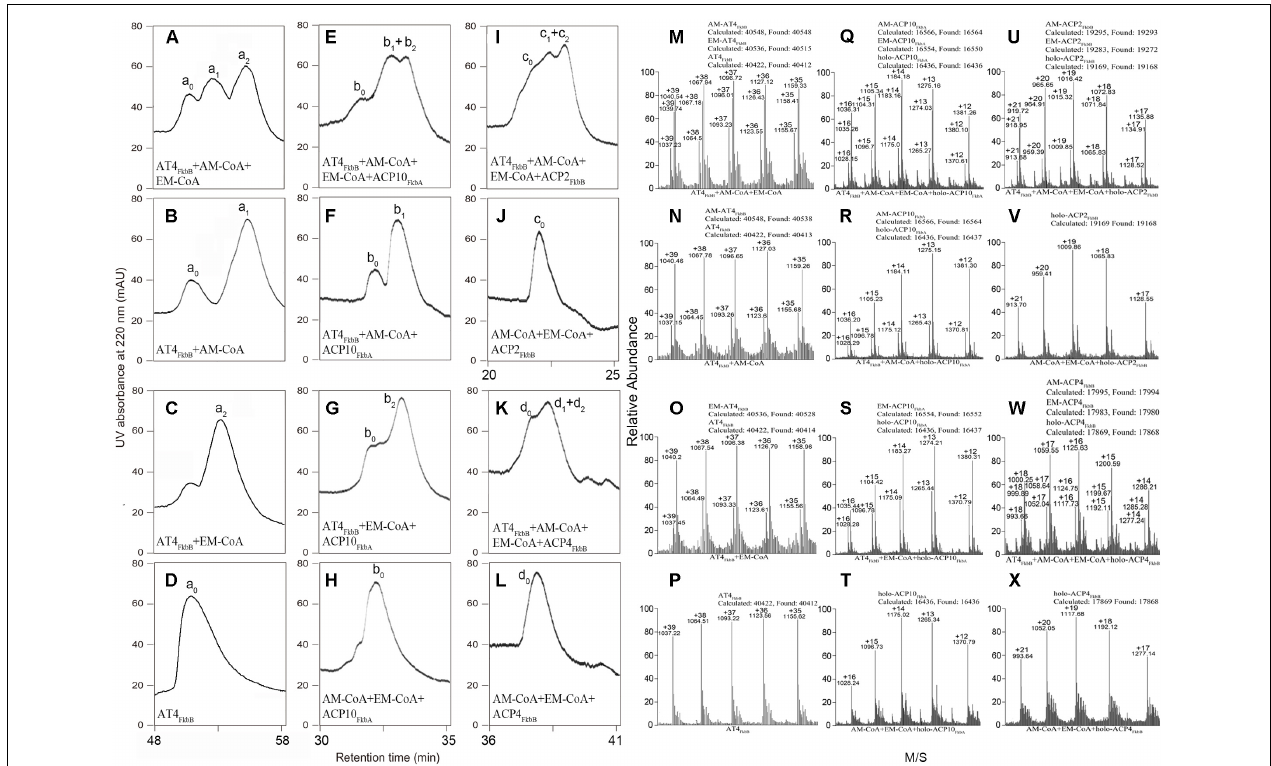
FIGURE 1 | HPLC and MS analyses of AT4 FkbB recognizing and transferring allmal- and ethmal-CoA in self -acylation reactions and onto diverse ACPs in trans -acylation reactions. (A–C,M–O) HPLC and MS analyses of incubation of AT4 FkbB with allmal-CoA : ethmal-CoA = 1:1 (A, M), allmal-CoA (B,N) , ethmal-CoA (C,O) . (D,P) HPLC and MS analyses of AT4 FkbB . (E–G,Q–S) HPLC and MS analyses of transferring allmal-CoA : ethmal-CoA = 1:1 (E,Q) , allmal-CoA (F,R) , ethmal-CoA (G,S) to holo-ACP10 FkbA in the presence of AT4 FkbB . (H,T) HPLC and MS analyses of incubation of holo-ACP10 FkbA with allmal-CoA : ethmal-CoA = 1:1. (I,J,U,V) HPLC and MS analyses of transferring allmal-CoA : ethmal-CoA = 1:1 to holo-ACP2 FkbB in the presence of AT4 FkbB (I,U) and in the absence of AT4 FkbB (J,V) . (K,L,W,X) HPLC and MS analyses of transferring allmal-CoA : ethmal-CoA = 1:1 to holo-ACP4 FkbB in the presence of AT4 FkbB (K,W) and in the absence of AT4 FkbB (L,X) . The peaks were assigned as follows: a 0 , AT4 FkbB ; a 1 , allmal-AT4 FkbB ; a 2 , ethmal-AT4 FkbB ; b 0 , holo-ACP10 FkbA ; b 1 , Allmal-ACP10 FkbA ; b 2 , ethmal-ACP10 FkbA ; c 0 , holo-ACP2 FkbB ; c 1 , allmal-ACP2 FkbB ; c 2 , ethmal-ACP2 FkbB ; d 0 , holo-ACP4 FkbB ; d 1 , allmal-ACP4 FkbB ; d 2 , ethmal-ACP4 FkbB